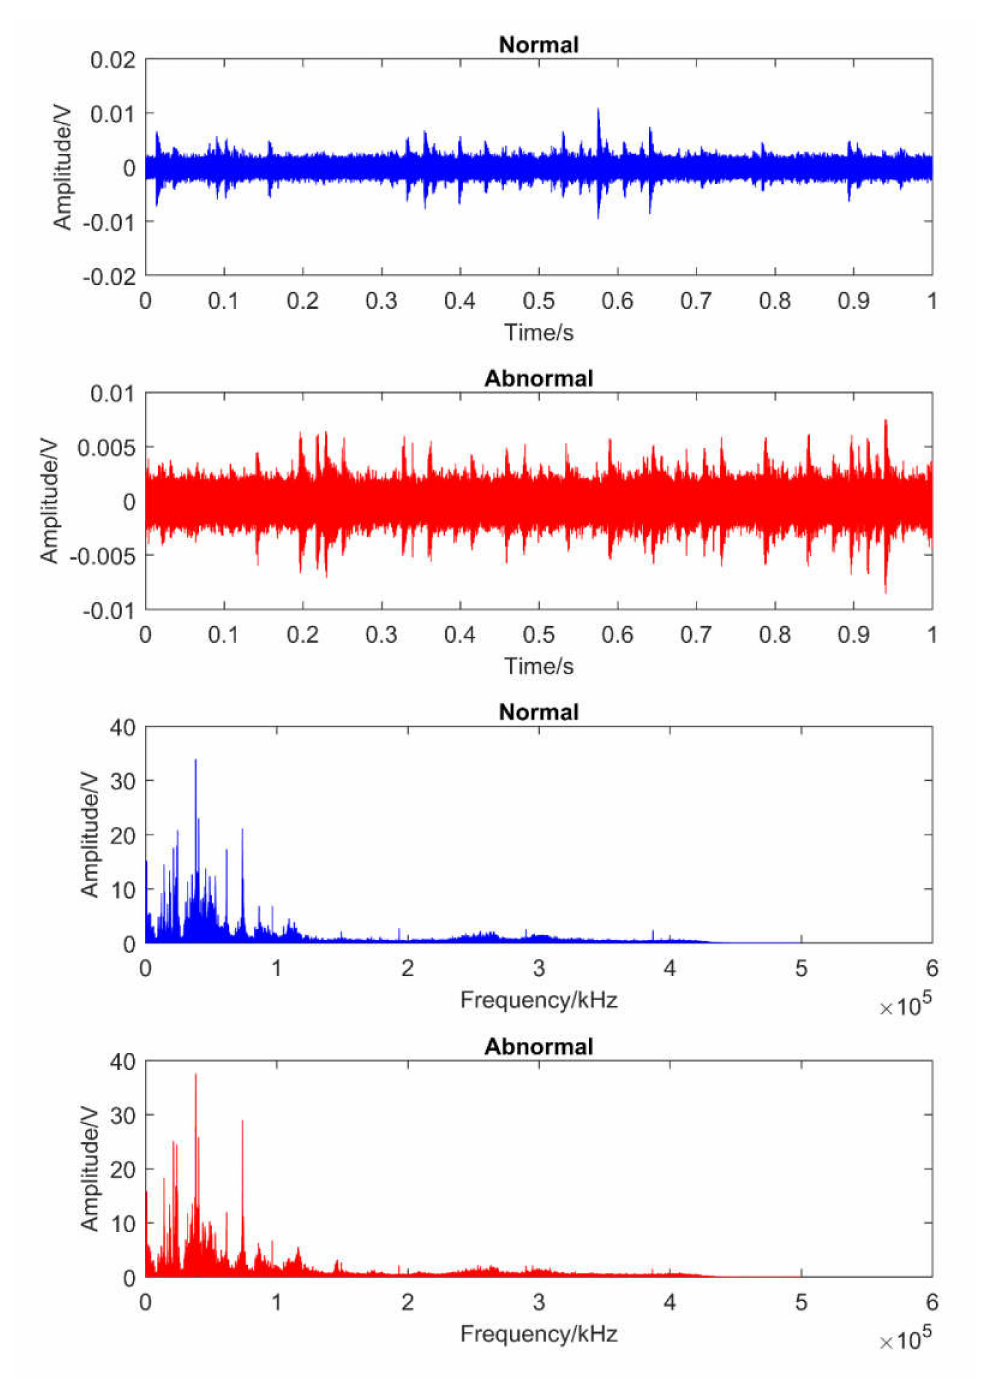
Figure 8. The illustration of the obtained AE signals in dataset 2 over the time and frequency domains. To extract the most informative part of the signals, sub-bands were first produced by implementing the DWPT on each raw AE signal. Then, the optimal sub-band was selected depending on the minimum wavelet entropy before being employed to restore the AE signal. Figure 9 shows the di ff erence between signals before and after denoising in both the time and frequency